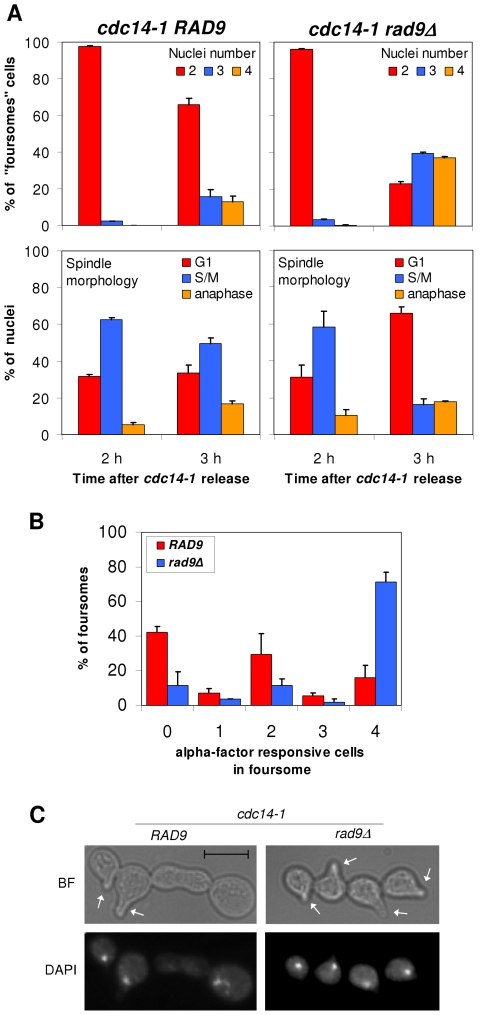
The G2/M arrest that follows a cdc14-1 release is dependent on Rad9.(A) Strains FM459 (cdc14-1 TUB1-GFP) and FM576 (cdc14-1 rad9Δ TUB1-GFP) were arrested at 37°C for 3 h and then released. Samples were taken and micrographed 2 and 3 hours after the release. Upper panels show nuclei number after DAPI staining for the major foursome category. Lower panels indicate spindle morphologies for each nucleus in the foursomes (mean ± SEM, n = 3). (B) Strains FM515 (cdc14-1 RAD52-YFP) and FM883 (cdc14-1 rad9Δ RAD52-YFP) were arrested and released as in A. Two hours after the release, alpha-factor was added and cells were then incubated for 3 more hours before samples were taken and micrographed. Chart represents how many cells in each foursome responded to alpha-factor. Note how cdc14-1 RAD9 was distributed in three major categories peaking at 0, 2 and 4 responsive cells; whereas most cdc14-1 rad9Δ foursomes had all cells responding to alpha-factor (i.e., all progeny passed the G2/M arrest) (mean ± SEM, n = 2). (C) Representative cells of a cdc14-1 RAD9 foursome with two cells responding to alpha-factor and a cdc14-1 rad9Δ foursome with all its 4 cells responding (white arrows point to the shmoo). Note how there are 3 nuclei in the former (two of them in each of the responding cells) and 4 nuclei in the latter (see main text for more details).